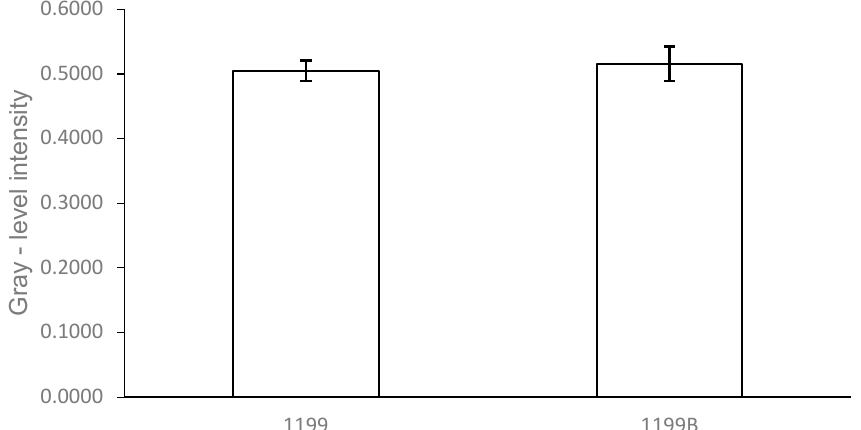
Figure 6. Average growth and standard deviation after 24 h of 1199 and 1199B strains without the interference of pyrogallol.